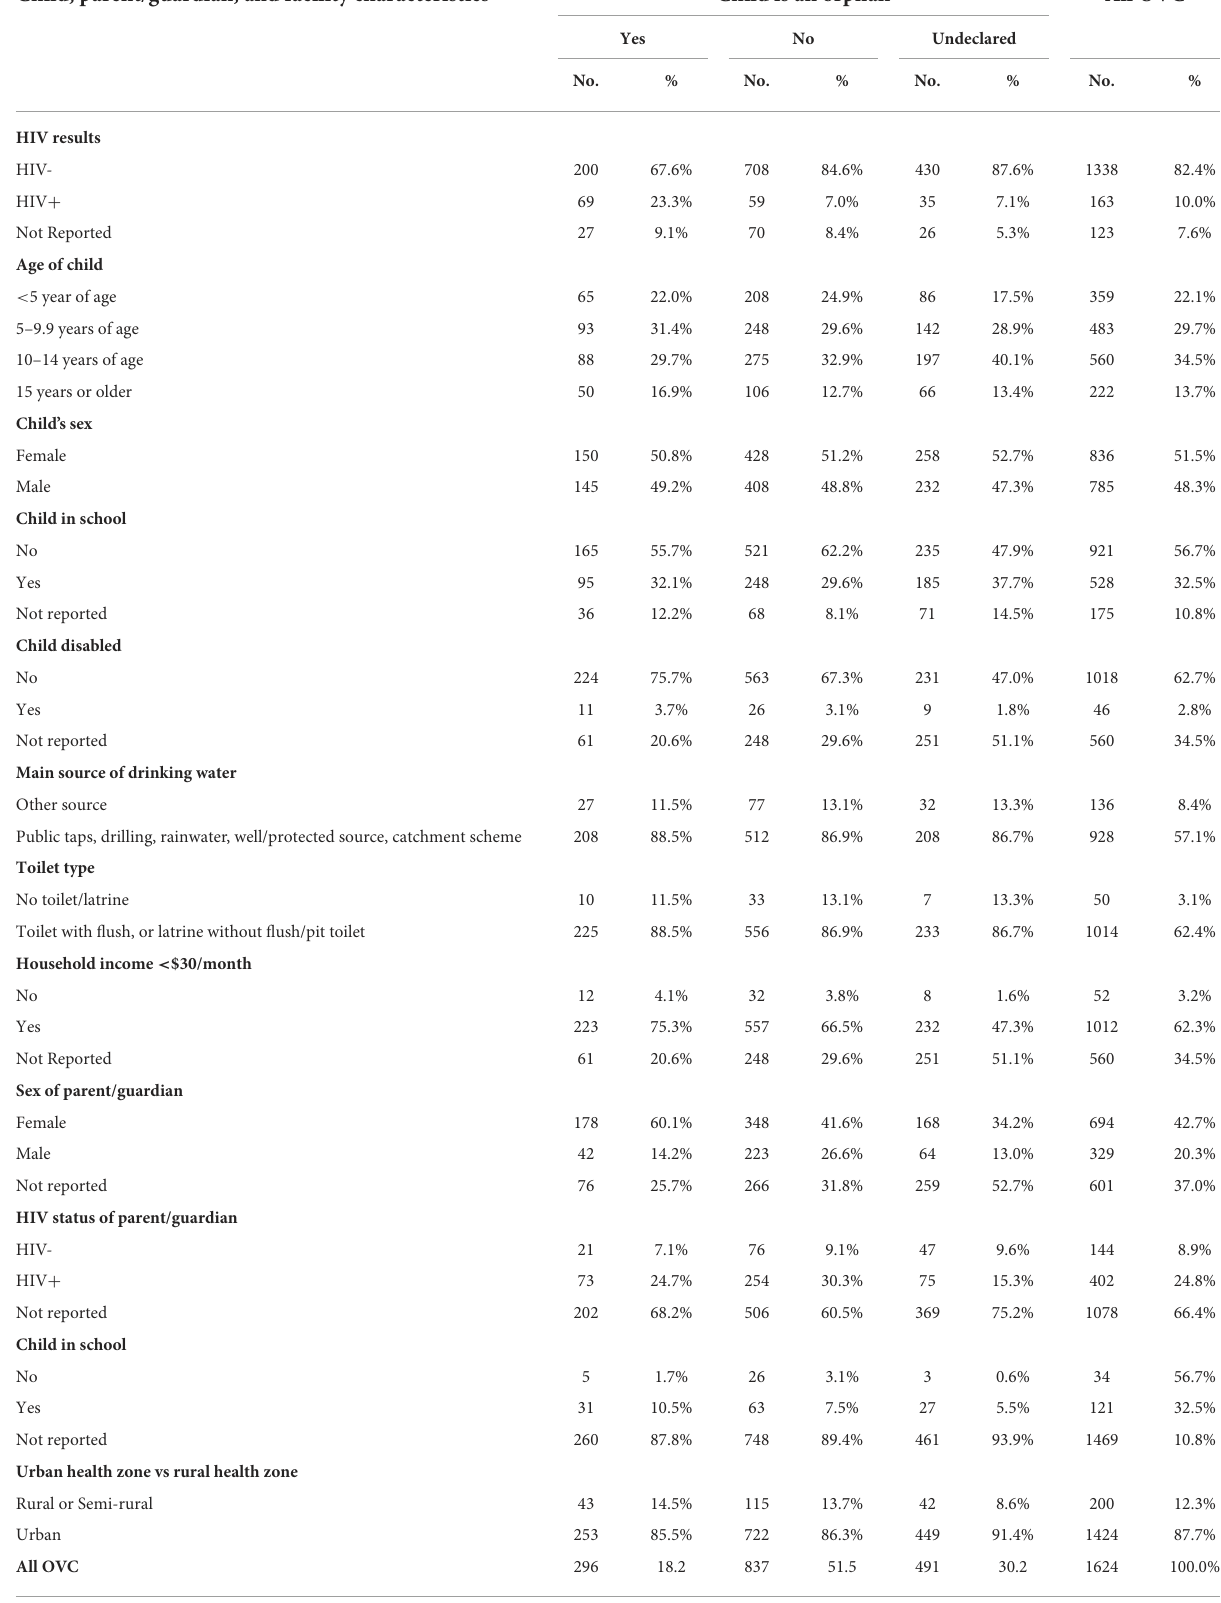
TABLE 1 Descriptive statistics for OVC, stratified by orphan status, Jan. 2017 to Apr. 2020. Child, parent/guardian, and facility